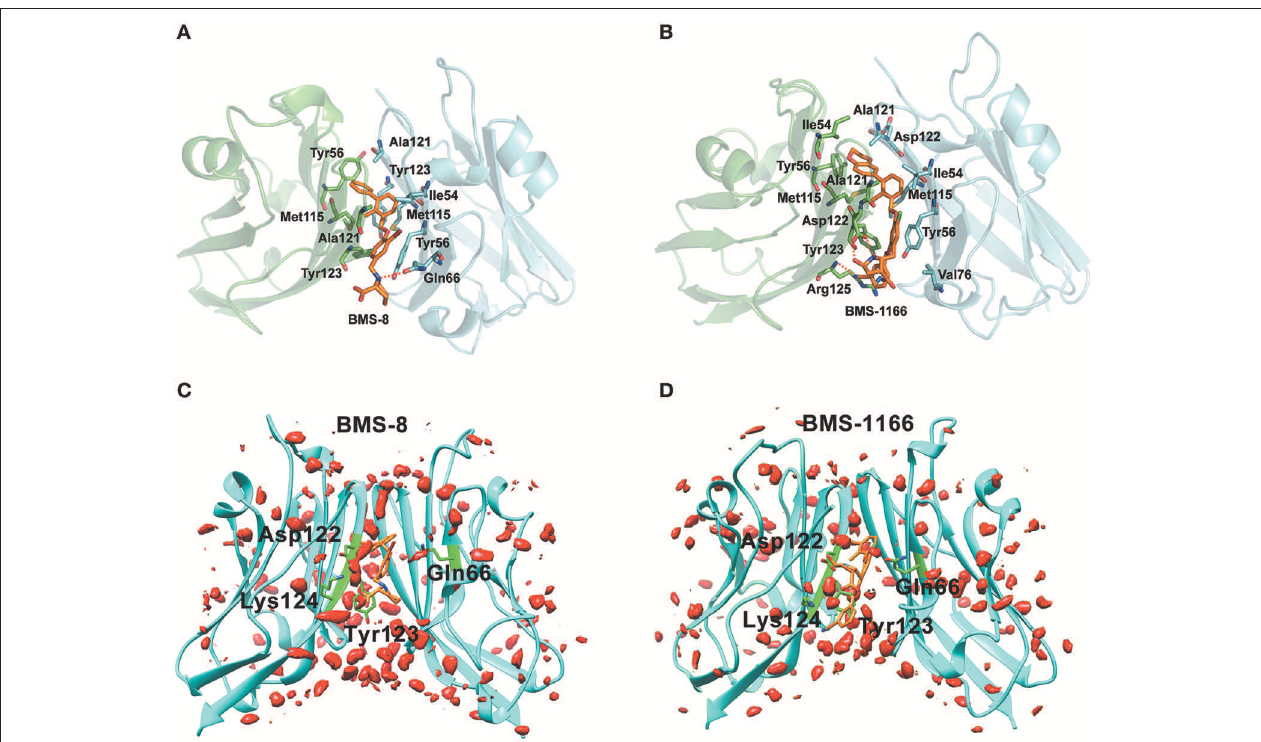
FIGURE 5 | The binding modes and water occupancies in dimer systems. (A,B) The binding modes of BMS-8 and BMS-1166. The key residues were shown in green and cyan sticks and the ligand was shown in orange sticks. The hydrogen bonds were shown in red dash. (C,D) The water occupancies in BMS-8 and BMS-1166 dimer systems. The PD-L1 dimer is shown in cyan cartoon and the residues involved in water bridges are shown in green sticks. The water distributions are shown in red solid surface and the small molecule ligands are shown in orange sticks.